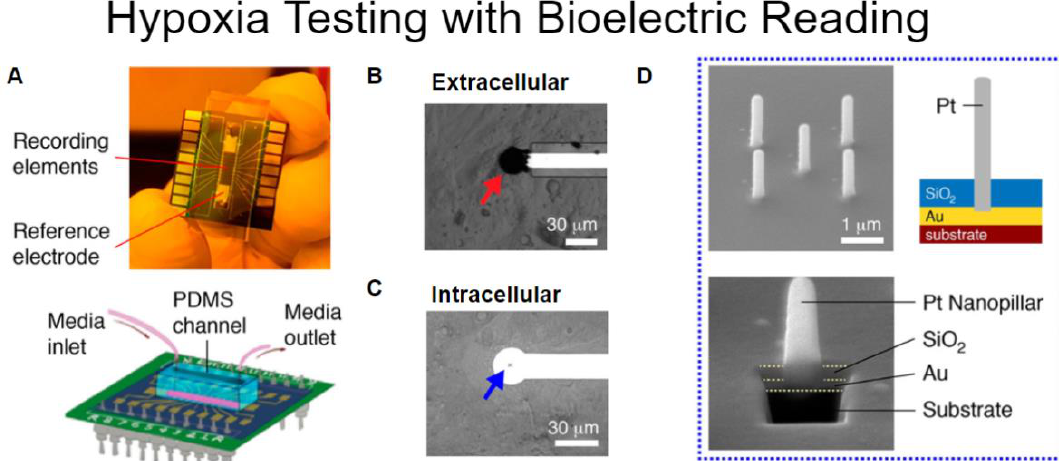
Figure 7. ( A ) Lap on a Chip made to measure the bioelectrical signals that cardiomyocytes produce. Visual reference top and schematic bottom. ( B ) Image of an extracellular element that cells grow on top of, in black. ( C ) a small arrangement of five intracellular platinum elements for cells to grow around. ( D ) Top left an arrangement of five platinum nanopillars for measurement. Bottom left cut out showing platinum nanopillar penetration into the Au layer. Right cross-section of single platinum nanopillar. Adapted from Liu et al [14].